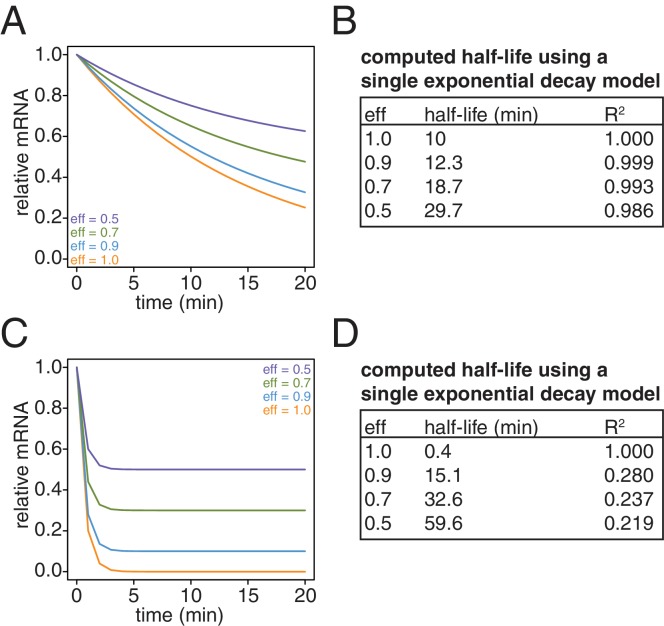
Simulation of the effects of non-ideal efficiencies in labeling and streptavidin bead separation on decay kinetics.(A) Decay data for an mRNA with a 10 min half-life were simulated with variable degrees of labeling and purification efficiencies. (B) The simulated data in (A) were fit to a single exponential decay model (RNA(t)=RNA(0)*2 t/hl where hl is the half-life) and the half-lives and goodness of fits (R2) were determined. (C) Decay data for an mRNA with a 0.4 min half-life were simulated with variable degrees of labeling and purification efficiencies. (D) The simulated data in (C) were fit to a single exponential decay model (RNA(t)=RNA(0)*2 t/hl where hl is the half-life) and the half-lives and goodness of fits (R2) were determined.